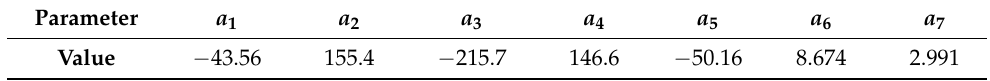
Table 1. Curve fitting